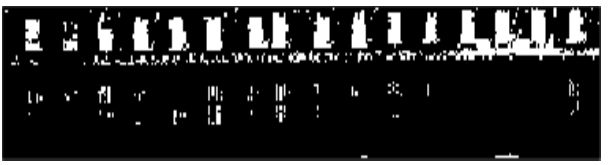
Figure 8. inner point s’ binary image (IPBI)